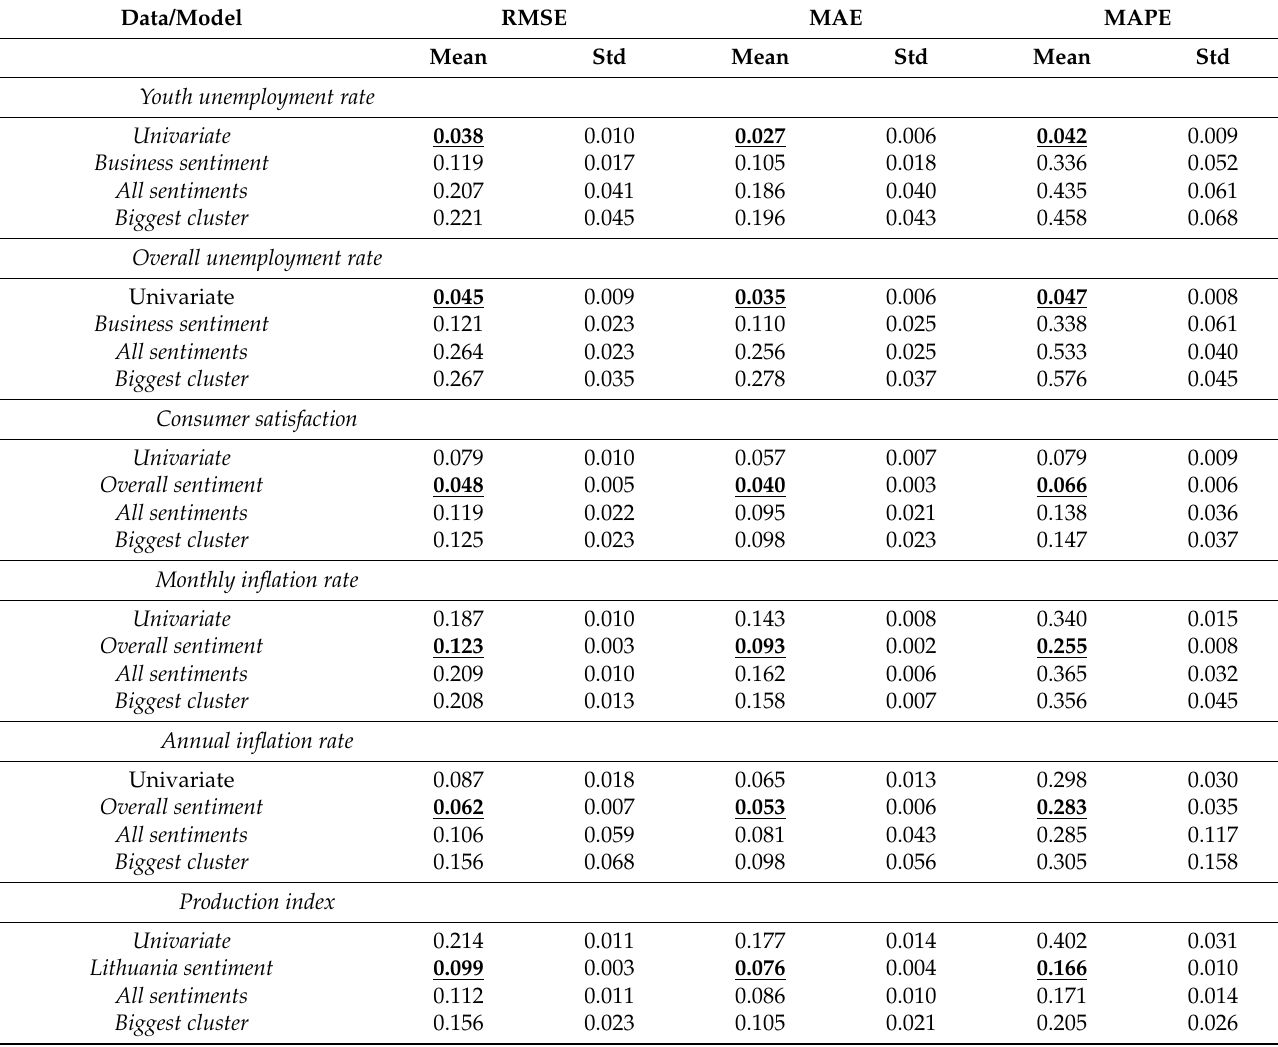
Table 4. Results of economic activity forecasting based on univariate time series and multivariate time